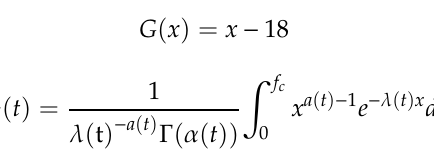
λ 2 ) with f c ) with